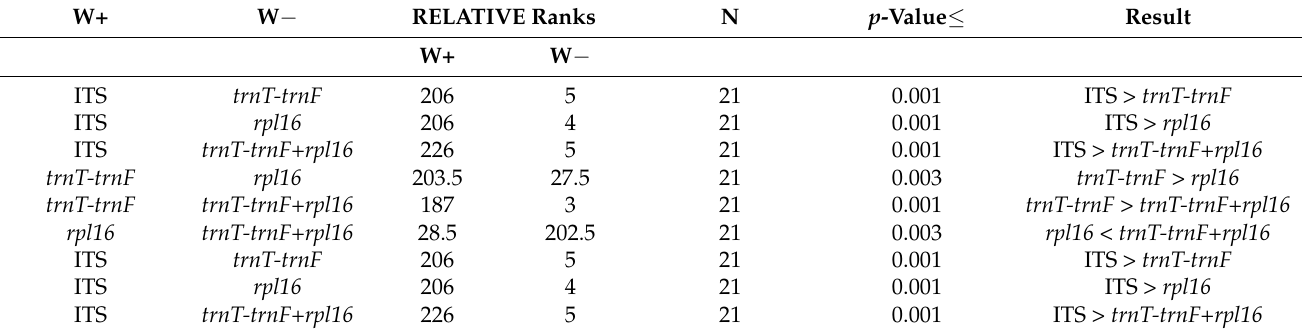
Table 3. Wilcoxon signed-rank tests 1 among the interspecific divergence of each DNA